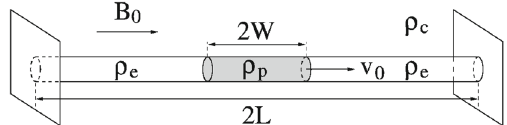
Fig.89 Sketchofthemagneticandplasmaconfigurationusedtorepresentaflowingthread(shadedvolume) inathinmagnetictube.Thetwoparallelplanesatbothendsofthecylinderrepresentthephotosphere.Image reproduced with permission from Terradas et al. (2008), copyright by